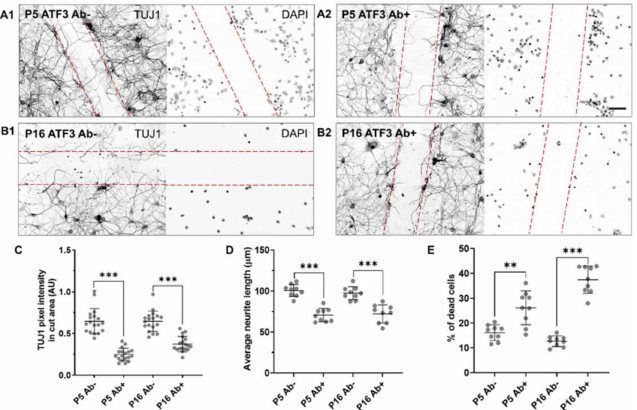
Figure 8. Inhibition of neuroregeneration by ATF3 antibody. ( A1 , B1 ) represents a control neuronal culture treated with PBS only. ATF3 antibody was added to P5 ( A2 ) and P16 ( B2 ) opossum cortical neurons in cell culture medium at DIV9 immediately after scratch. Neurons were fixed 24 h later and immunostained for TUJ1 (left panels). Nuclei were counterstained for DAPI (right panels). The scratch area is defined by the red dashed lines. Scale bar is 50 µ m. ( C ) Scatter plot represents P5 and P16 average TUJ1 pixel intensities. Data are shown as mean ± SD. For each condition, 2 ROIs of 3 random fields per sample from 3 culture preparations were analyzed. Welch’s t -test, P5 Ab- vs. P5 Ab+ p < 0.001 ***. Unpaired t -test, P16 Ab- vs. P16 Ab+ p < 0.001 ***. ( D ) Scatter plot represents P5 and P16 average neurite length of TUJ1-positive neurons. Data are shown as mean ± SD. Number of neurites analyzed: P5 Ab- 270; P5 Ab+ 230; P16 Ab- 245; P16 Ab+ 214. Unpaired t -test P5 Ab- vs. P5 Ab+ p < 0.001 ***. Unpaired t -test, P16 Ab- vs. P16 Ab+ p < 0.001 ***. ( E ) Scatter plot represents the percentage of dead cells for P5 and P16 cortical cultures. Data are shown as mean ± SD. Number of cells analyzed: P5 Ab- 608; P5 Ab+ 784; P16 Ab- 516; P16 Ab+ 433. Welch’s t test P5 Ab- vs. P5 Ab+ p = 0.002 **. Welch’s t test, P16 Ab- vs. P16 Ab+ p < 0.001 ***. Images of 3 random fields were analyzed per sample from 3 culture preparations. The accepted level of significance was p < 0.05. p <